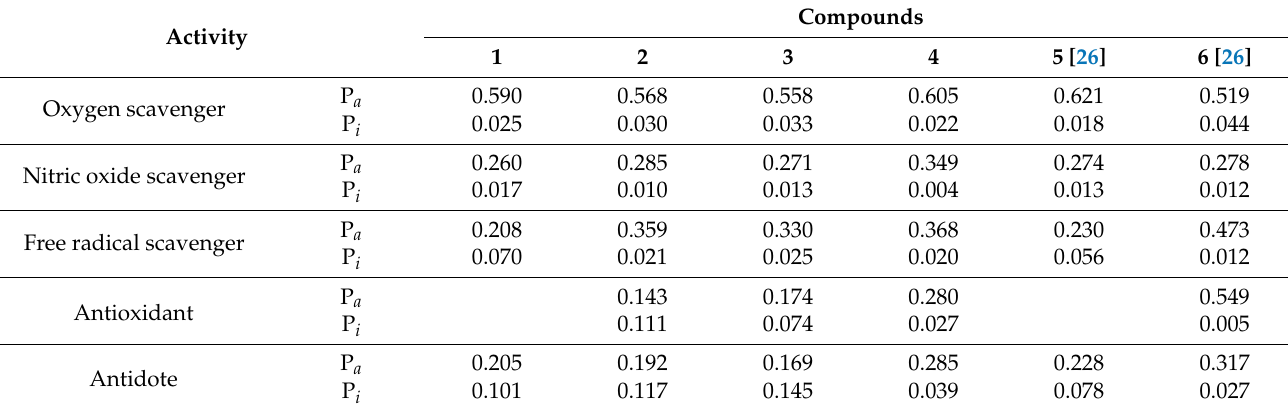
Table 1. Antioxidant activity and cytotoxicity prediction for compounds 1 – 6